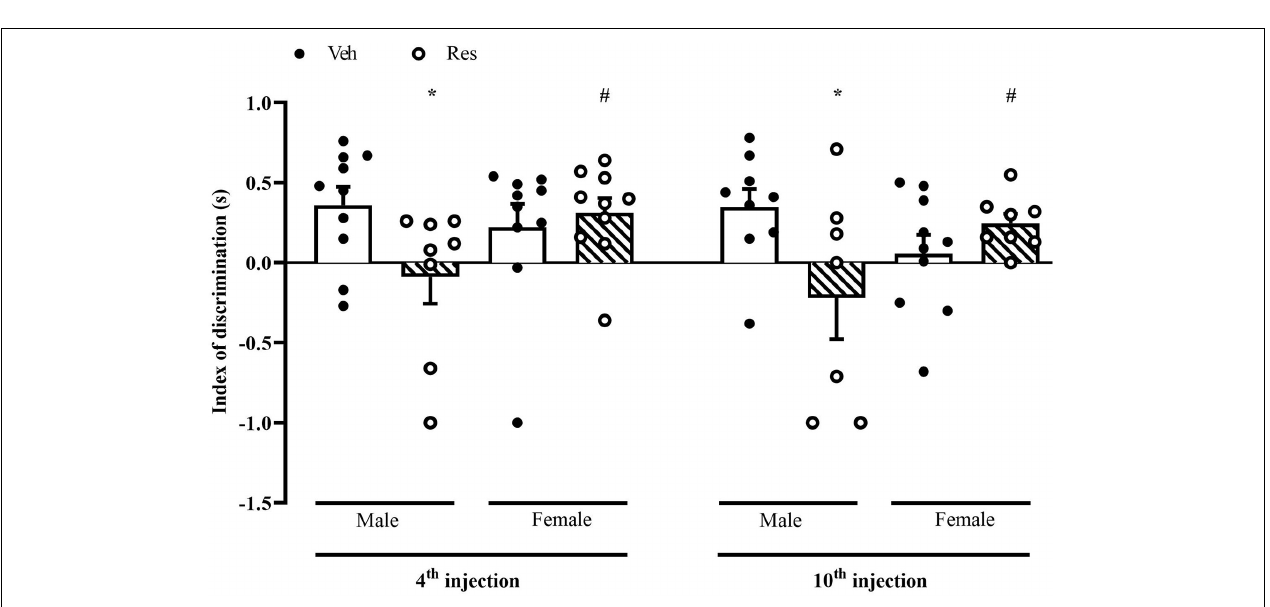
FIGURE 4 | Effects of repeated treatment with 0.1 mg/kg reserpine (Res) or vehicle (Veh) on locomotion in the open field in female and male rats. * p < 0.05 comparing RES and Veh. # p < 0.05 comparing males and females with the same treatment (Two-way repeated-measure ANOVA followed by Sidak’s post hoc test). Values were expressed by mean ± SEM. Black and circles represent individual data of Veh and Res animals, respectively.